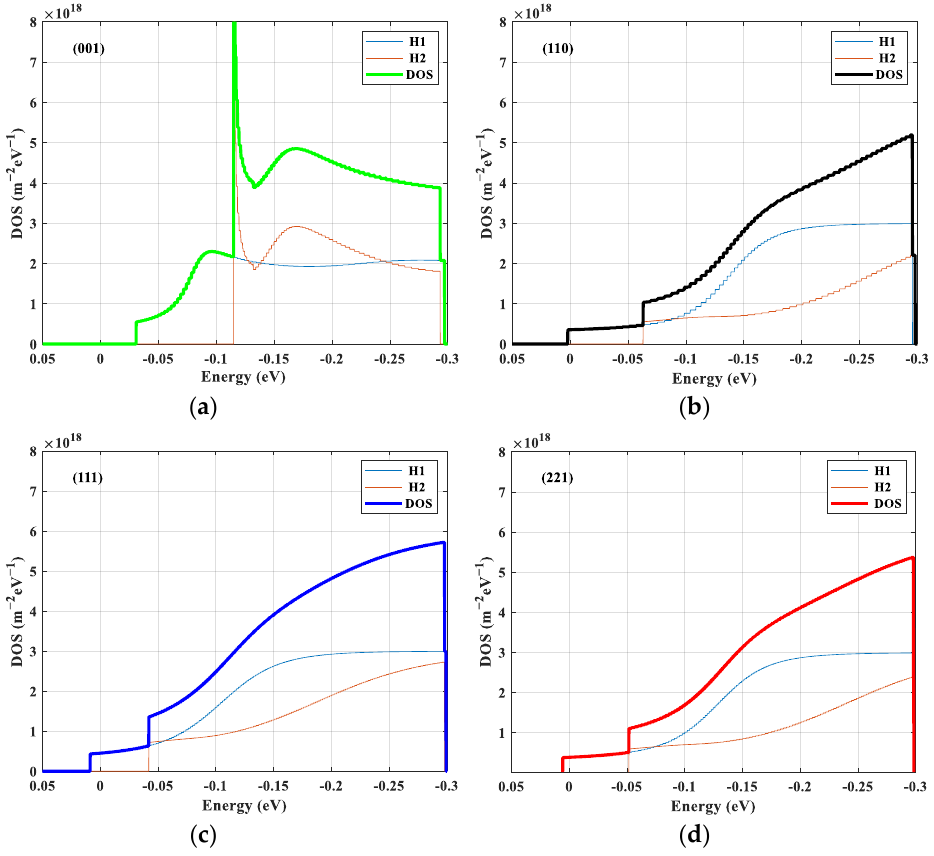
Figure 4. DOS for 1.06% compressive strained InGaAs QW structures with (a) (001), (b) (110), (c) (111), and (d) (221) orientations.